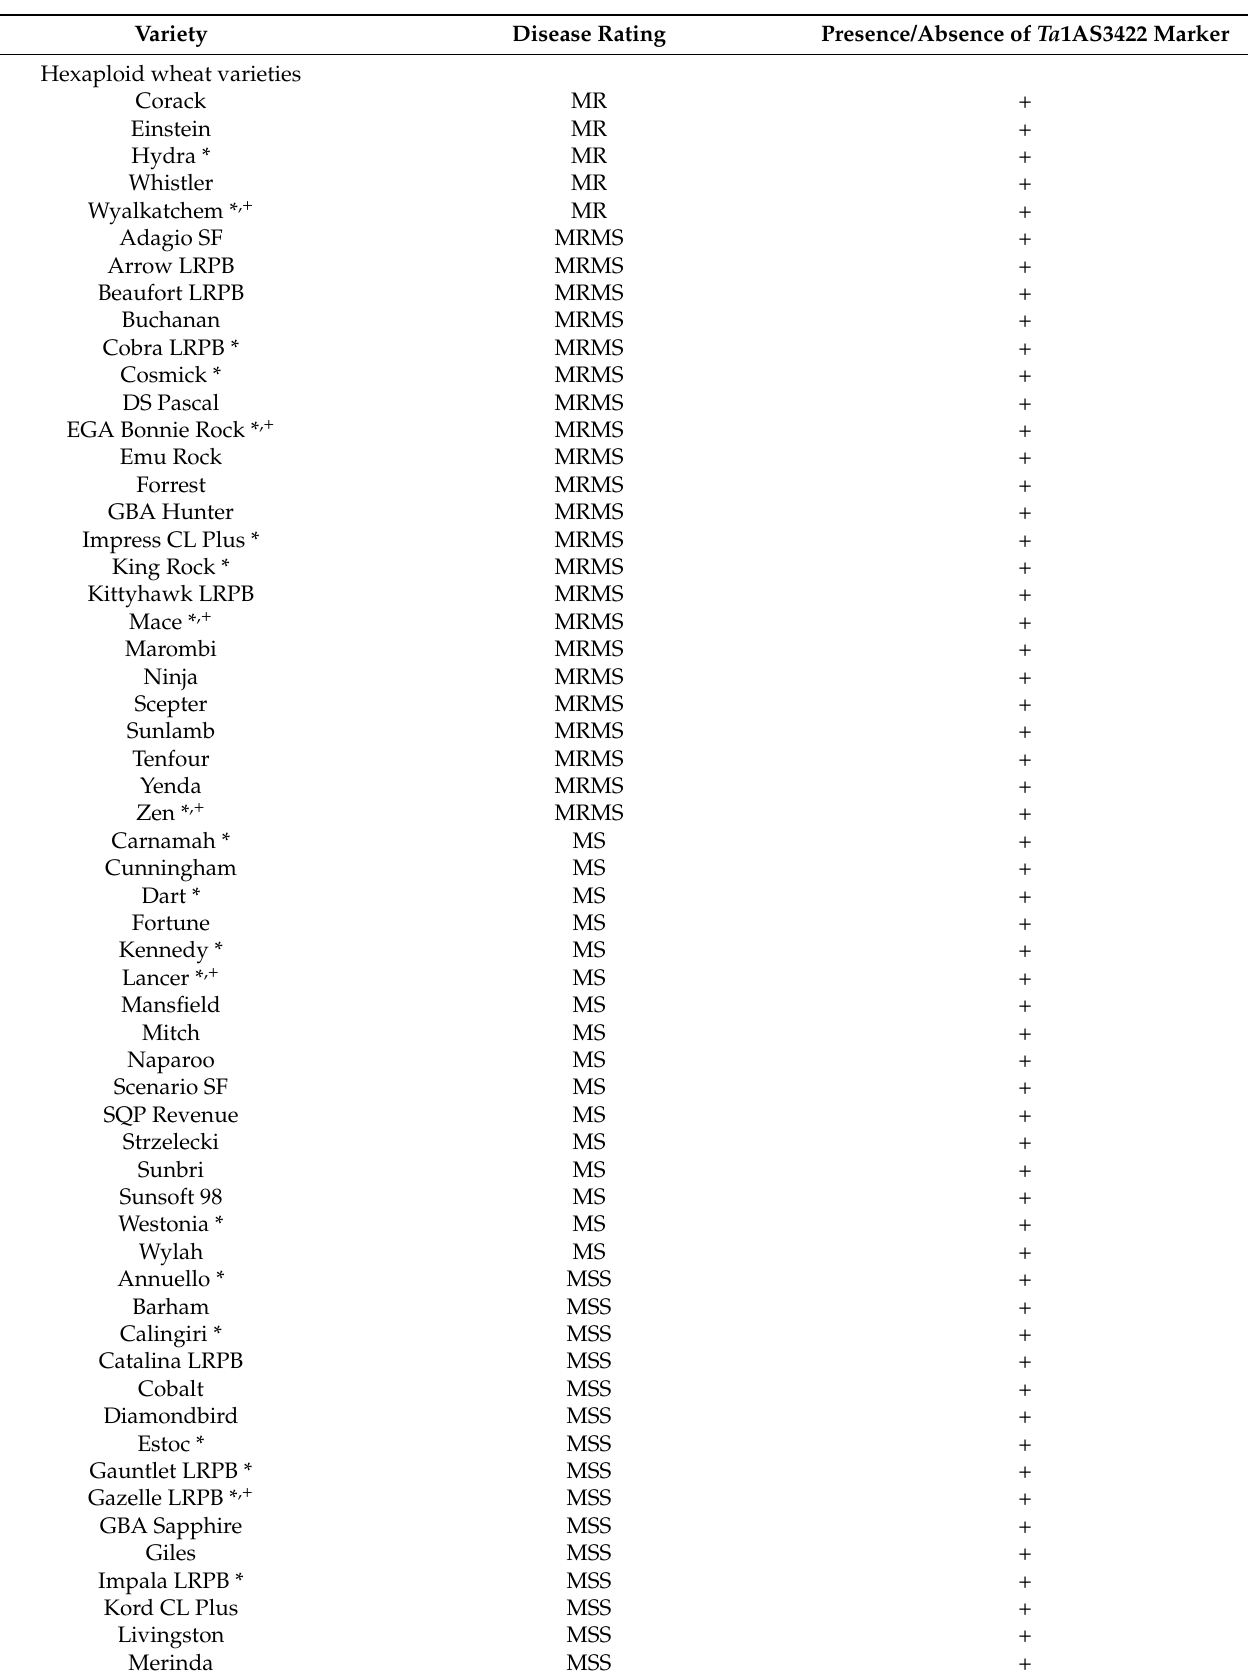
Table 2. Presence/absence of Ta 1AS3422 in Australian bread (hexaploid) wheat and durum (tetraploid) varieties. Variety Disease Rating Presence/Absence of Ta 1AS3422 Marker Hexaploid wheat